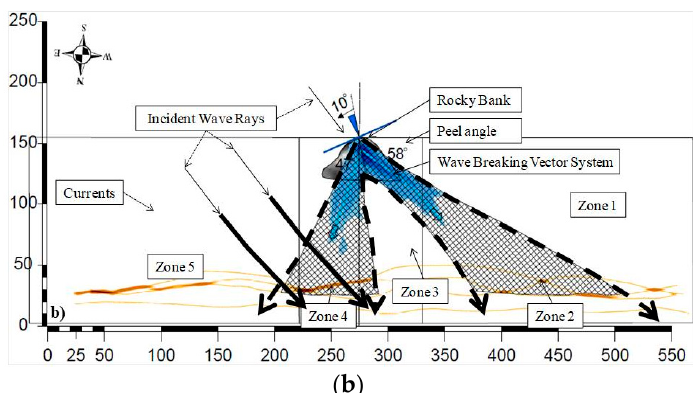
Figure 11. Wave-breaking vector system (blue lines) and the shoreline dynamic in the lee of the submerged structure (density occurrence as referred in Figure 10) for depositional ( a ) and erosive groups ( b ). Reference hydrodynamic zones observed around a rectangular submerged breakwater [40].